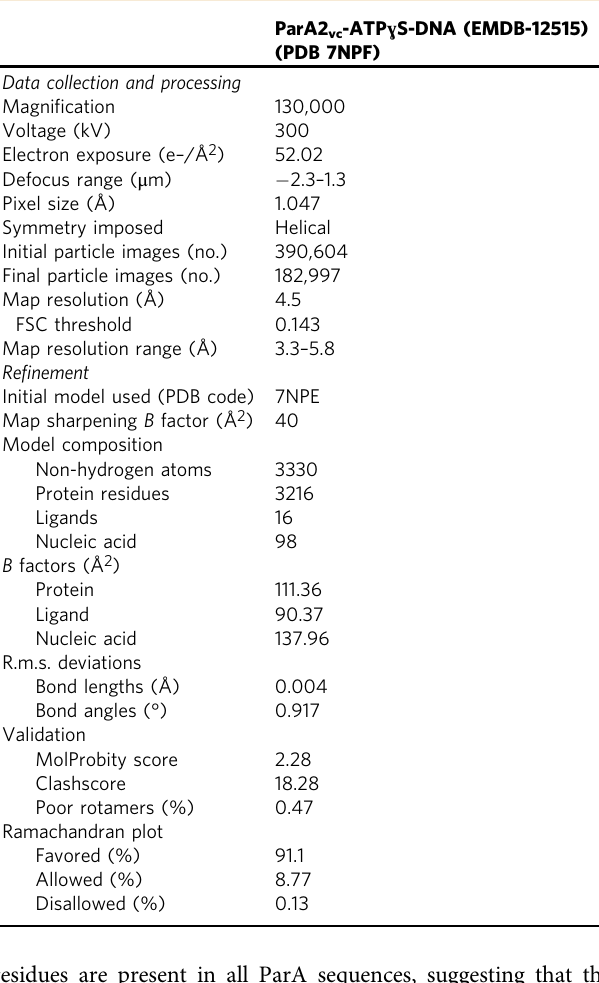
Table 2 Cryo-EM data collection, re fi nement, and validation